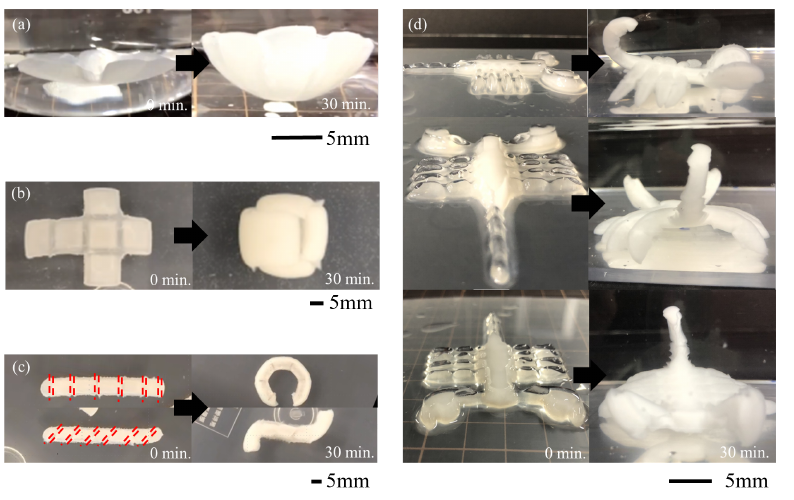
Figure 7. The before and after photographs of 4D printing of hydrogels controlled by hinge structure and spatially gradient swelling at 0 min and 30 min. ( a ) Jellyfish model (without hinge structure). ( b ) Cubic origami. ( c ) Warm models with two different hinge structures. ( d ) Scorpion